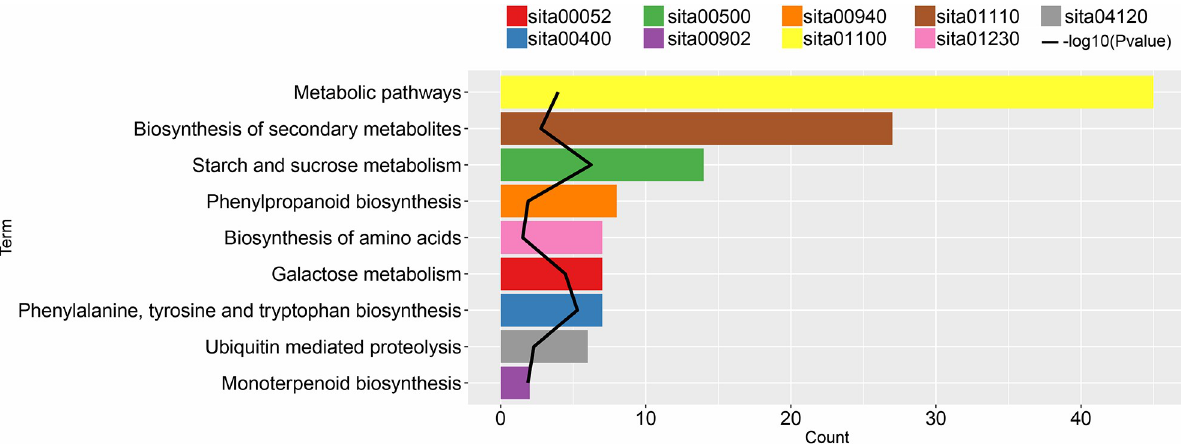
Fig 5. Pathway enrichment analysis of differentially expressed genes between groups D and DHA. Y-axis represents pathway annotation information; x-axis represents number of genes enriched in the pathway. The -log10 ( p -value) is represented as an inflection point of the broken line.